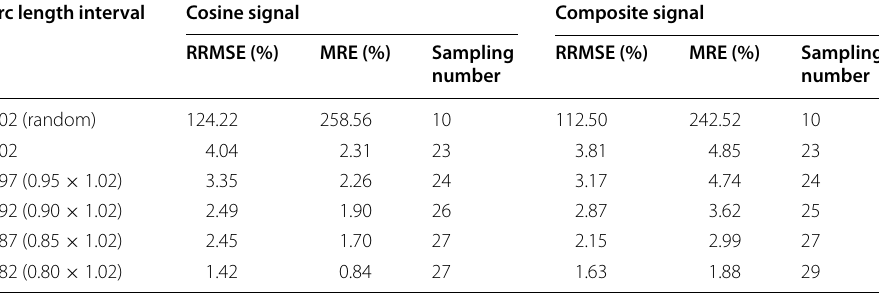
Table 2 Reconstruction error of nonuniform sampling Arc length interval Cosine signal